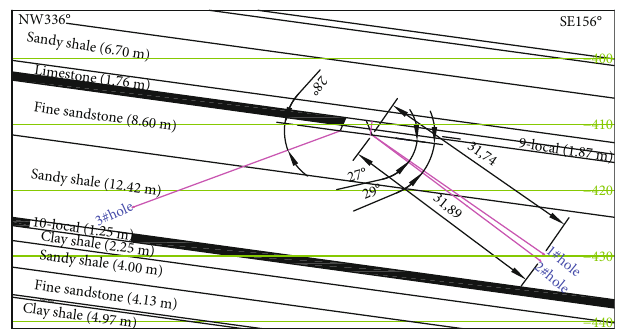
Figure 14: Drilling elevation plan.